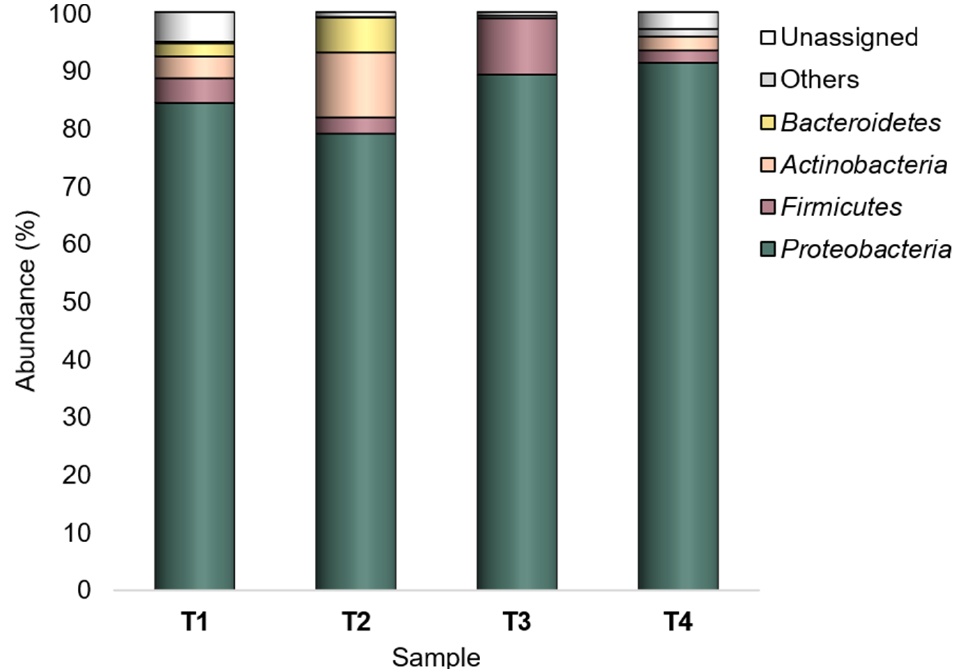
Figure 1. Bacterial composition at the phylum level. Distribution of the major phyla (Ra ≥ 1% in at least one sample); phyla with Ra < 1% were gathered in “Others”. T1: WT/OF, T2: WT/CF, T3: SB/OF, T4: SB/CF.